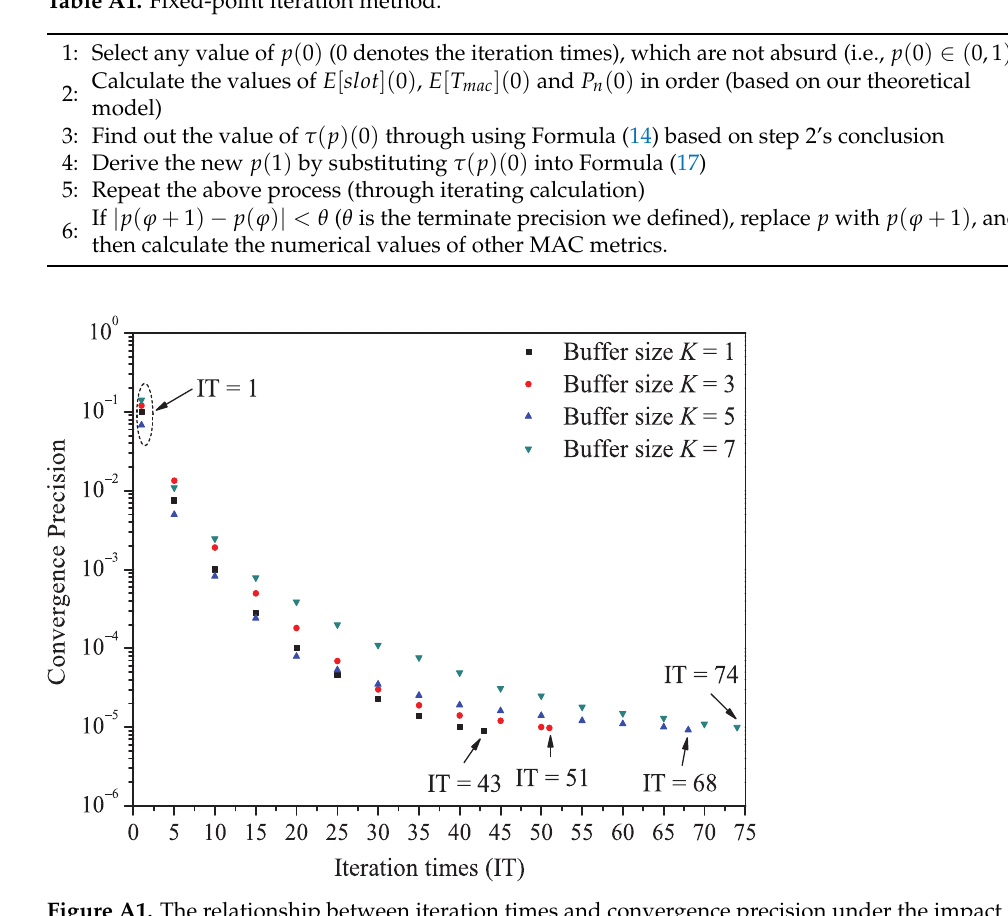
Table A1. Fixed-point iteration method.